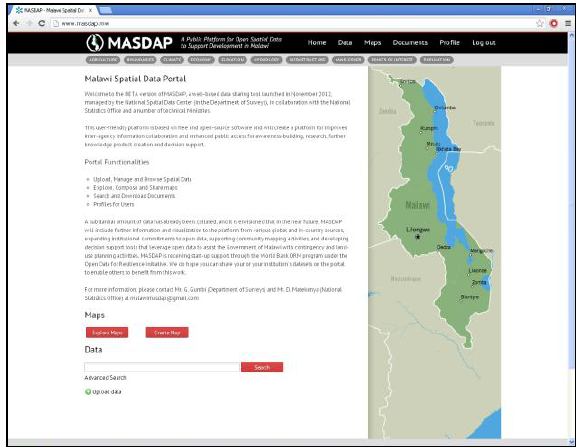
Figure 1. Screenshot of the MASDAP platform homepage